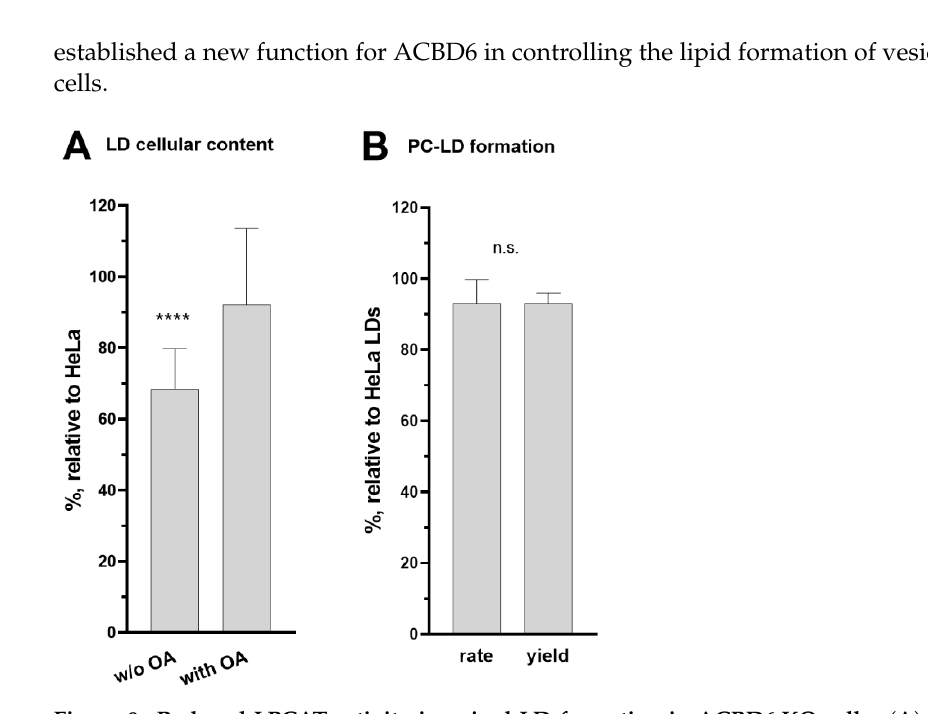
Figure 8. Reduced LPCAT activity impaired LD formation in ACBD6.KO cells. ( A ) . HeLa and ACBD6.KO cells were grown in 96-well plates in the absence or presence of 200 µ M oleic acid (OA) for 24 h. LD content was quantified with a Fluorometric Lipid Droplet staining (see Section 2) and was normalized to the protein cellular content, quantified with SRB staining. Values obtained with the ACBD6.KO cells are reported relative to the values obtained with HeLa cells. Error bars represent the standard deviations of values obtained from 21 measurements: ****, p < 0.000001. ( B ) . Re-acylation of lysoPC (20 µ M) by LDs isolated from ACBD6.KO and HeLa cells were performed with 5 µ M [ 14 C]C 16 -CoA and 0.8 µ g LD proteins. The rate of PC formation was calculated from 0 to 10 min and values obtained with ACBD6.KO are reported relative to the values obtained with HeLa cells. Thin-layer chromatography analysis of the reactions is presented in the bottom panel of Figure 7. Error bars represent the standard deviations of values obtained from 3 measurements. n.s. — not significant.